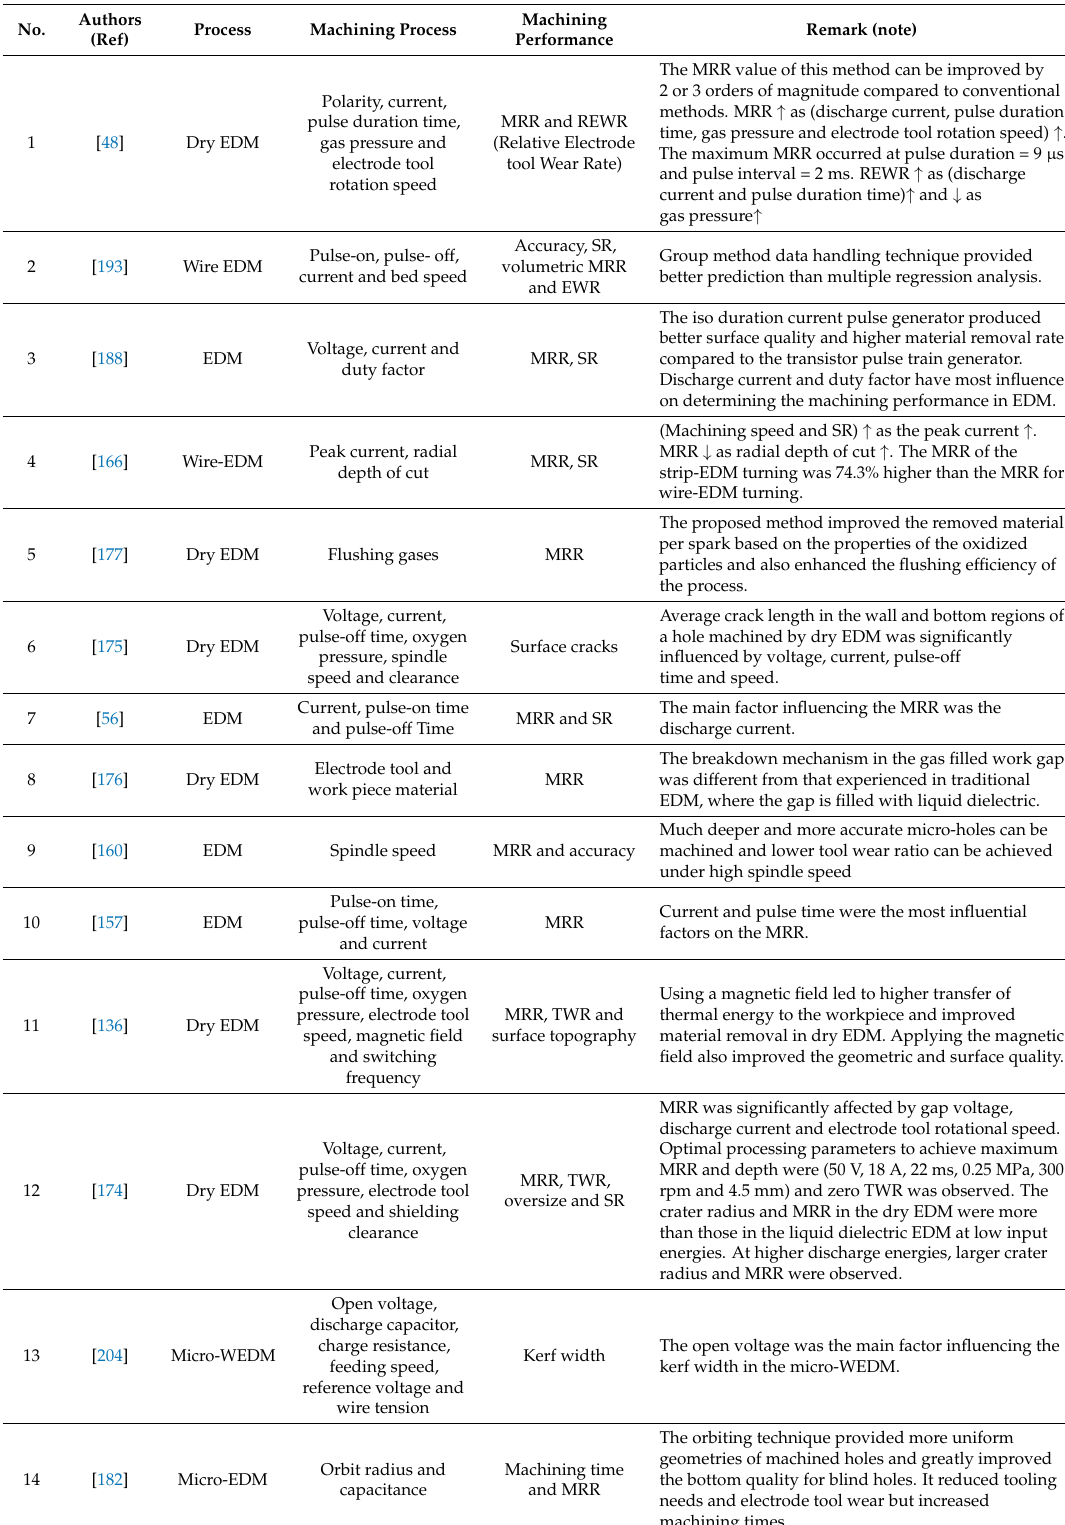
Table 3. Summary of selected studies in optimizing the machining process parameters of stainless steel.